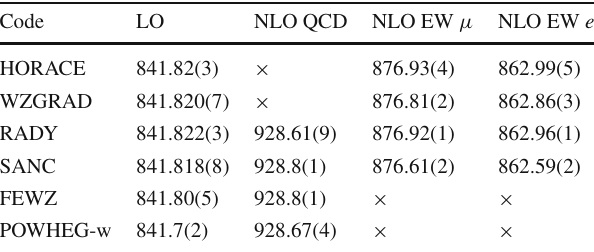
Table 13 pp → W + → l + ν l cross sections (in pb) at the 8 TeV LHC, with LHCb cuts and bare leptons